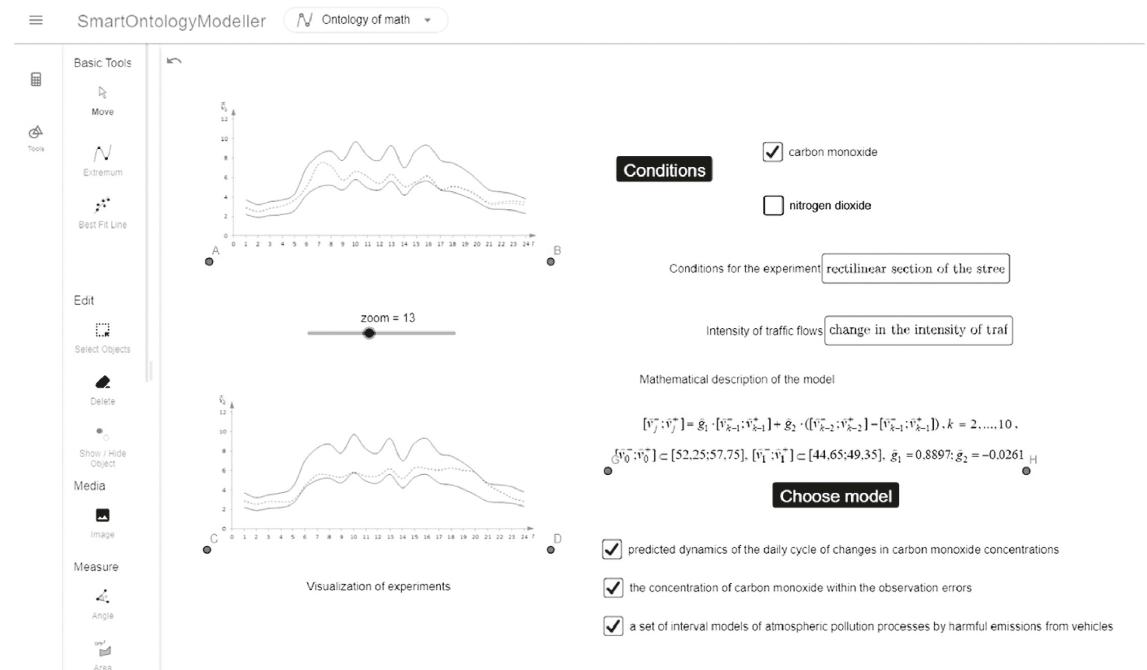
Figure 6: Example of switching the mathematical model due to the changes in the conditions of the simulation environment or the conditions of the corresponding experiment.